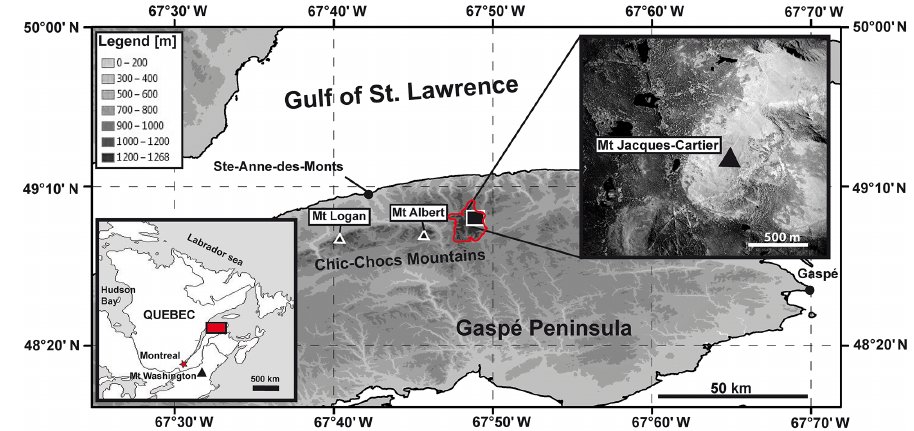
Figure 1. Study site. Mont Jacques-Cartier (1268ma.s.l.) is the highest summit of the Chic-Choc Mountains. It is surrounded by several summits exceeding 1100ma.s.l., e.g. Mont Logan (1150ma.s.l.) and Mont Albert (1154ma.s.l.). The red dashed line delineates the batholith of the McGerrigle Mountains. The Mont Jacques-Cartier summit forms a treeless dome above 1200 to 1220ma.s.l., where a typical alpine tundra environment is